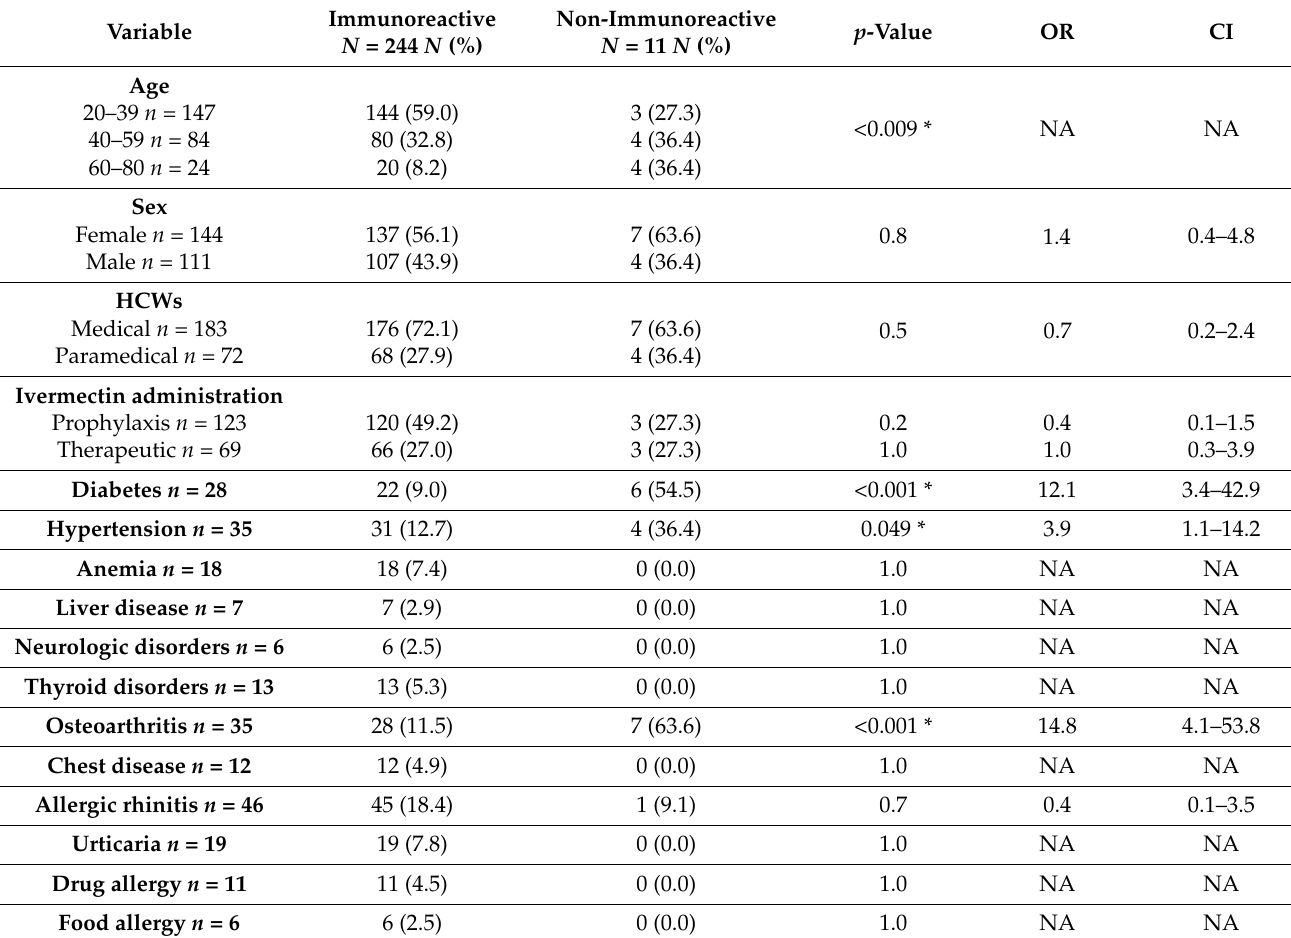
Table 4. Factors influencing Immunoreactivity to vaccine.